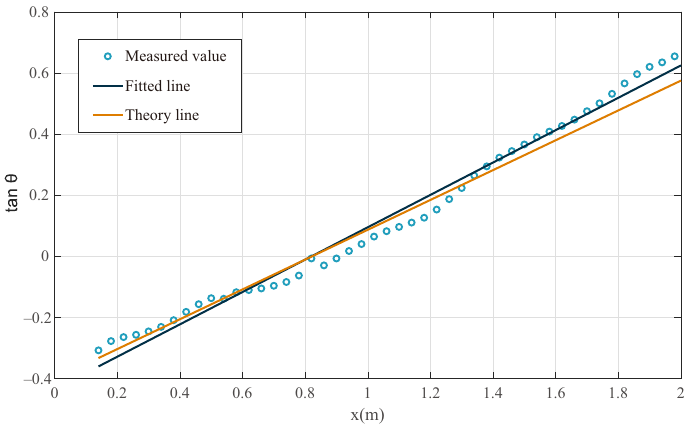
Figure 5. Linear model of DOA